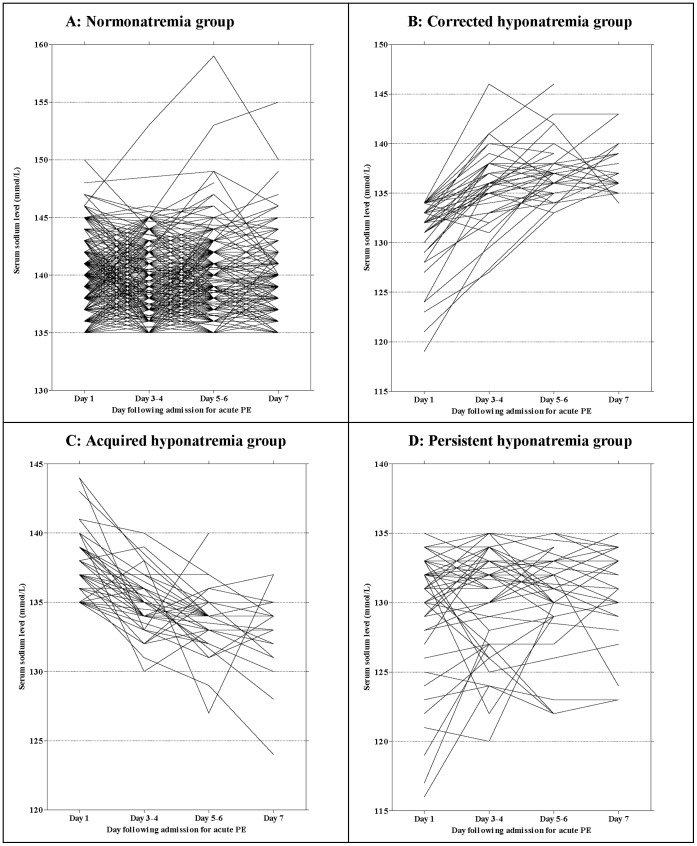
Natural history of serum sodium levels fluctuation during hospital admission for acute PE.The figures show the natural history of the study cohort’s serum sodium levels during the course of their admission for acute PE stratified into the four patterns of sodium fluctuation observed. Each line on the graph represents an individual patient and the time course of that individual’s serum sodium level fluctuations during admission is tracked along the x-axis, which shows the day following admission that individual’s serum sodium was assessed again. Hyponatremia is defined as having a serum sodium level less than 135 mmol/L.